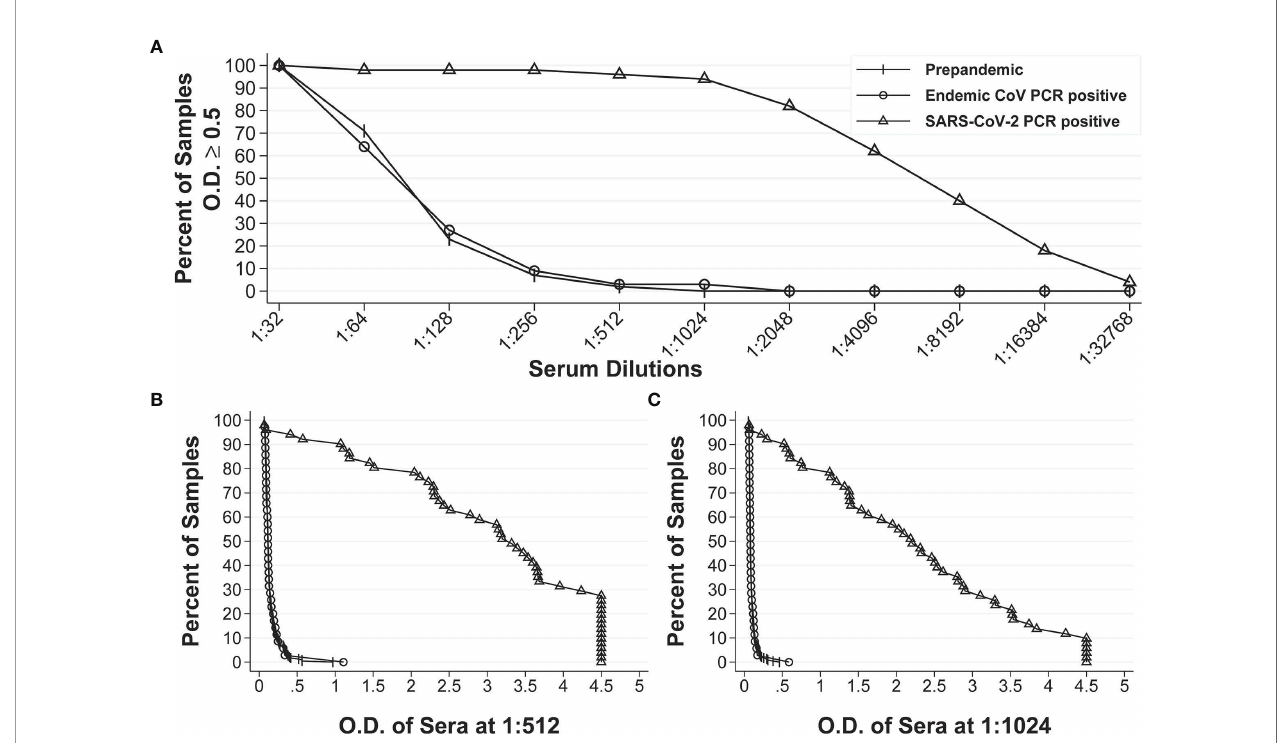
FIGURE 1 | Reverse cumulative distribution curves of IgG anti-S ELISA. (A) Percentages of positive sera among the pre-pandemic sera with unknown infectious status to endemic coronaviruses (n = 234), pre-pandemic human endemic coronavirus PCR positive sera (n=35), and SARS-CoV-2 PCR positive sera (n=51) at different dilutions at an O.D. ≥ 0.5. (B, C) Percentages of positive sera at different O.D. values for all three groups of sera at 1:512 dilution and 1:1024 dilution,